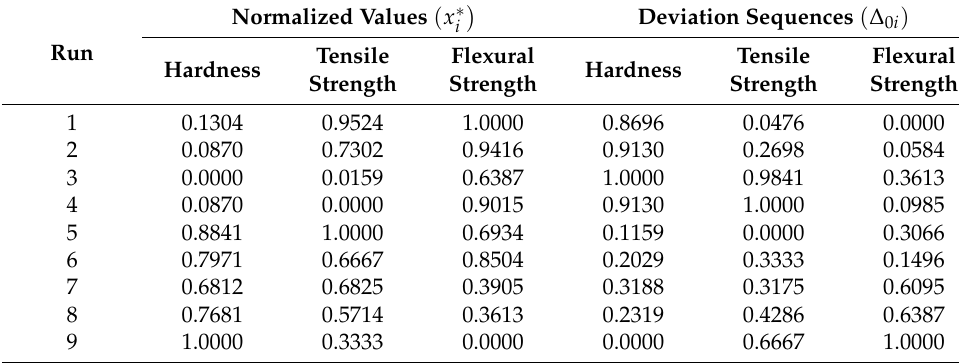
Table 8. Reference and deviation sequences.